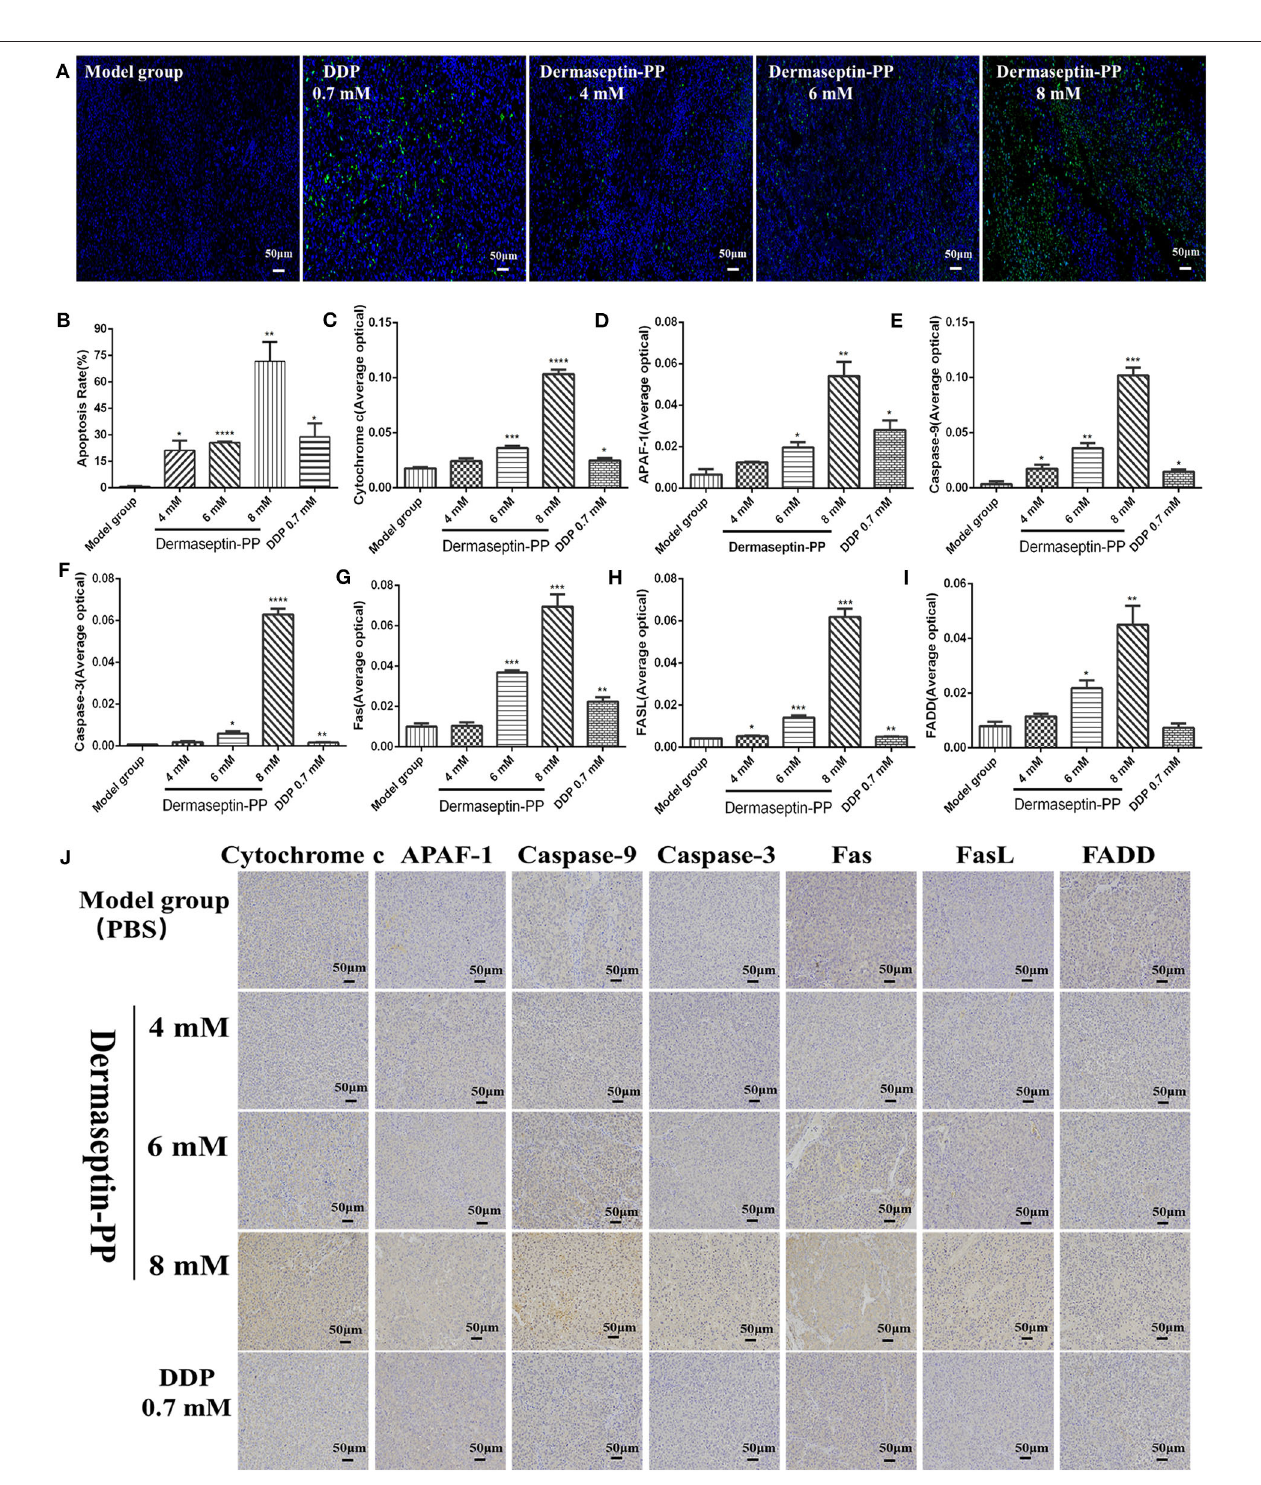
FIGURE 6 | Representative images (A) and histological images analysis (B) of TUNEL staining for detection of apoptosis in H157 cells ( × 200). The yellow-green stained cells in the nucleus are positive (apoptotic) cells and the blue-stained cells in the nucleus are normal cells. Data was analyzed with unpaired Student’s t -test using GraphPad Prism 5 software. **** P < 0.0001, ** P < 0.01, * P < 0.05 vs. model control group (PBS). The immunohistochemical analysis was used to determine the expression of (C) Cytochrome c (D) Apaf-1 (E) Caspase-9 (F) Caspase-3 (G) Fas (H) FasL (I) FADD in tumor tissue isolated from mice treated under various conditions. **** P < 0.0001, *** P < 0.001, ** P < 0.01, * P < 0.05 vs. model control group (PBS). (J) The representative images of immunohistochemical. Original magnification, × 200. The deeper the yellow, the higher the apoptosis-related protein expression. The average optical density (AOD) of each tumor tissue section was analyzed by Image-Pro Plus software and is shown in the bar graph on the right of the images. The higher the AOD, the higher the level of the apoptosis protein. Data was analyzed with unpaired Student’s t -test using GraphPad Prism 5 software. ** P < 0.01, * P < 0.05 vs. model control group.